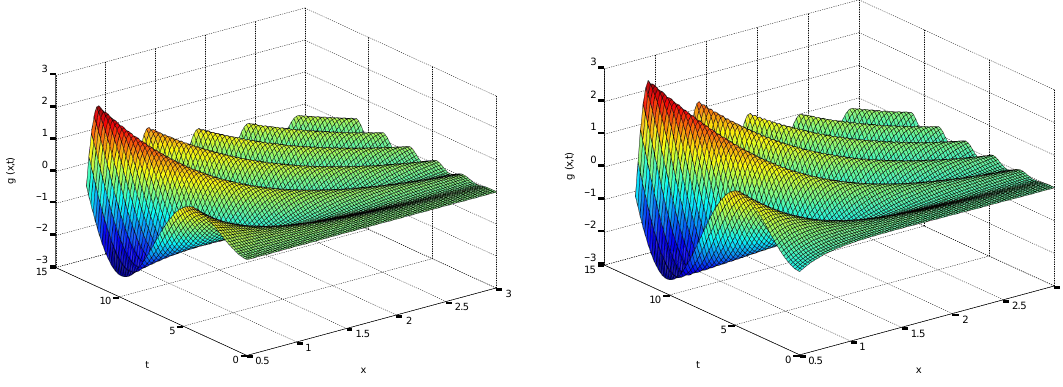
Fig. 1. Exact (top) and approximate (bottom) solution g.x;t/ when ˛ D 0:8 and g 0 .x/ D ln x